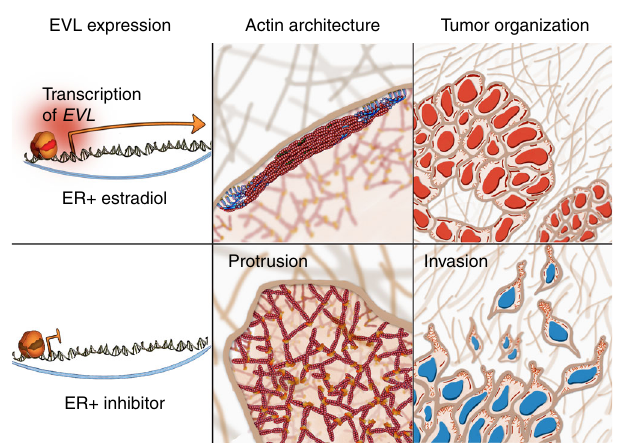
Fig. 8 Model: Suppression of breast cancer cell invasion by ER. ER activates EVL transcription. EVL inhibits invasion by generating SCABs (suppressive cortical actin bundles), which suppress protrusive activity. ER inhibition leads to decrease in EVL levels and increase in protrusive activity and invasion. Red nuclei represent ER